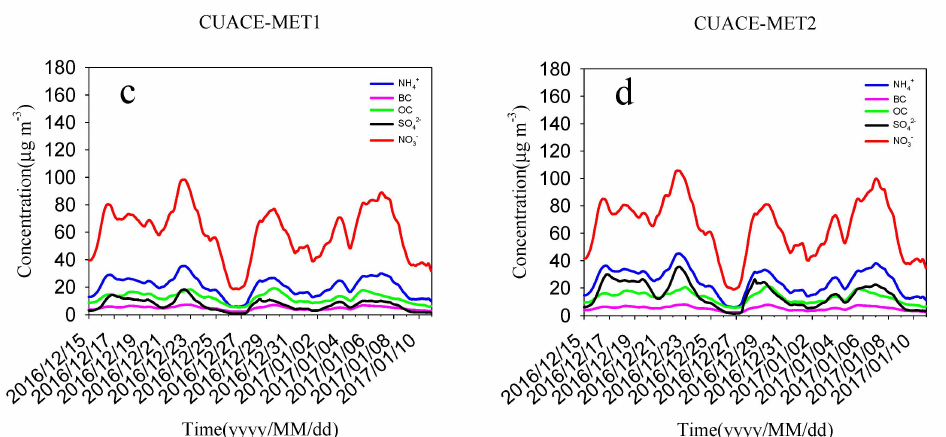
Figure 8. Time series of daily averages of the concentrations of ammonium (blue solid line), BC (purple solid line), OC (green solid line), sulfate (blue solid line), and nitrate (red solid line) by